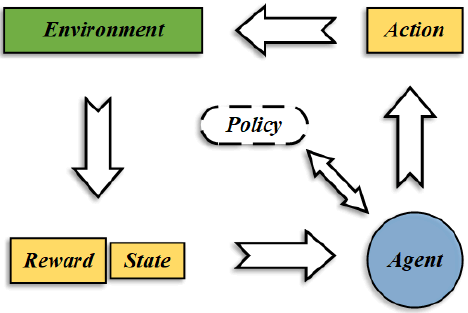
Figure 4. Schematic diagram for reinforcement learning.